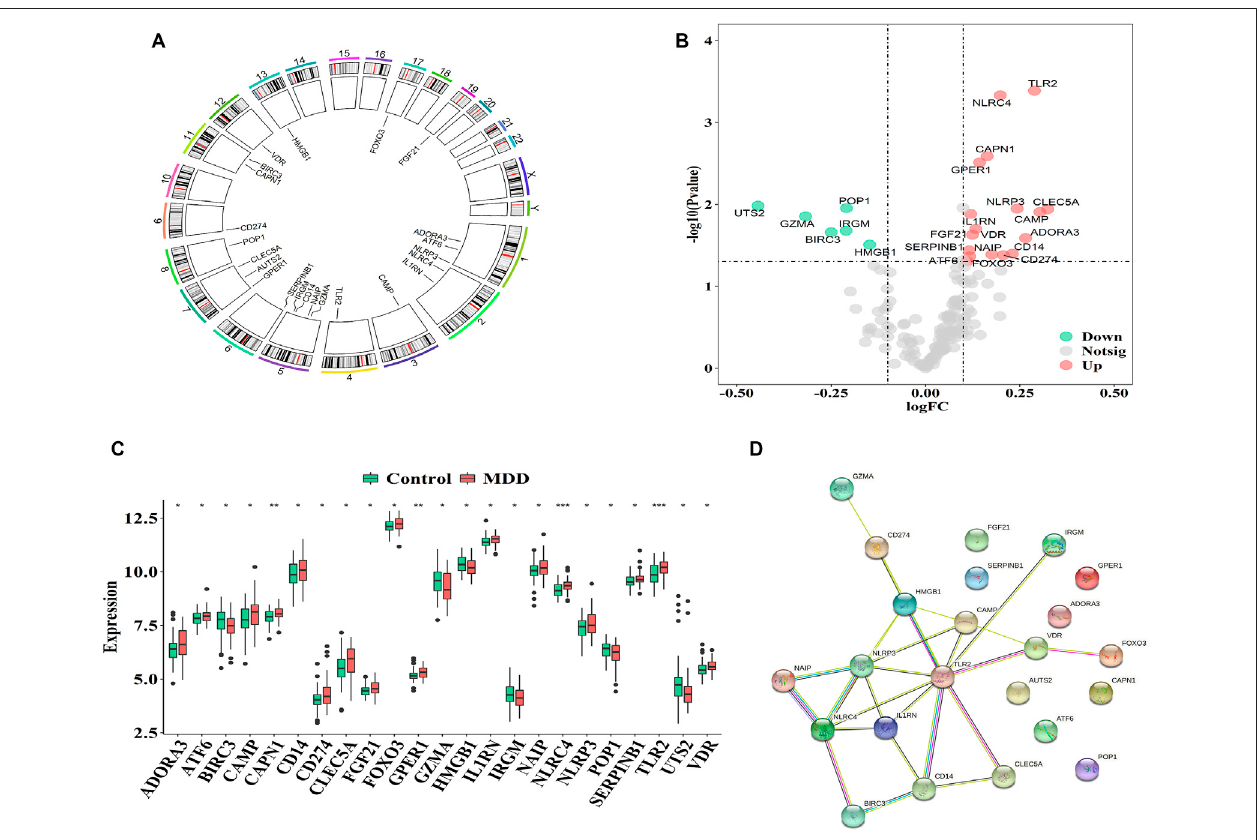
FIGURE 1 | Characterization of pyroptosis-related genes in MDD (A) . The location of pyroptosis-related genes on chromosomes by GSE98793 (B – C) . The Volcano and heat map of 23 differentially expressed pyrotopsis-related genes (D) . Box plot of differential expression of 23 differentially expressed pyrotopsis-related genes in control and depression samples. Adjusted p -values were showed as: ns, not signi fi cant; * p < 0.05; ** p < 0.01; *** p <